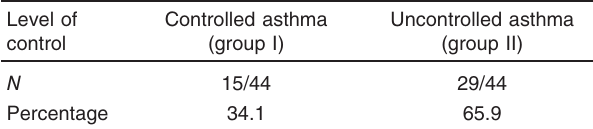
Table 1 Level of control in the study groups, based on asthma control test Level of control